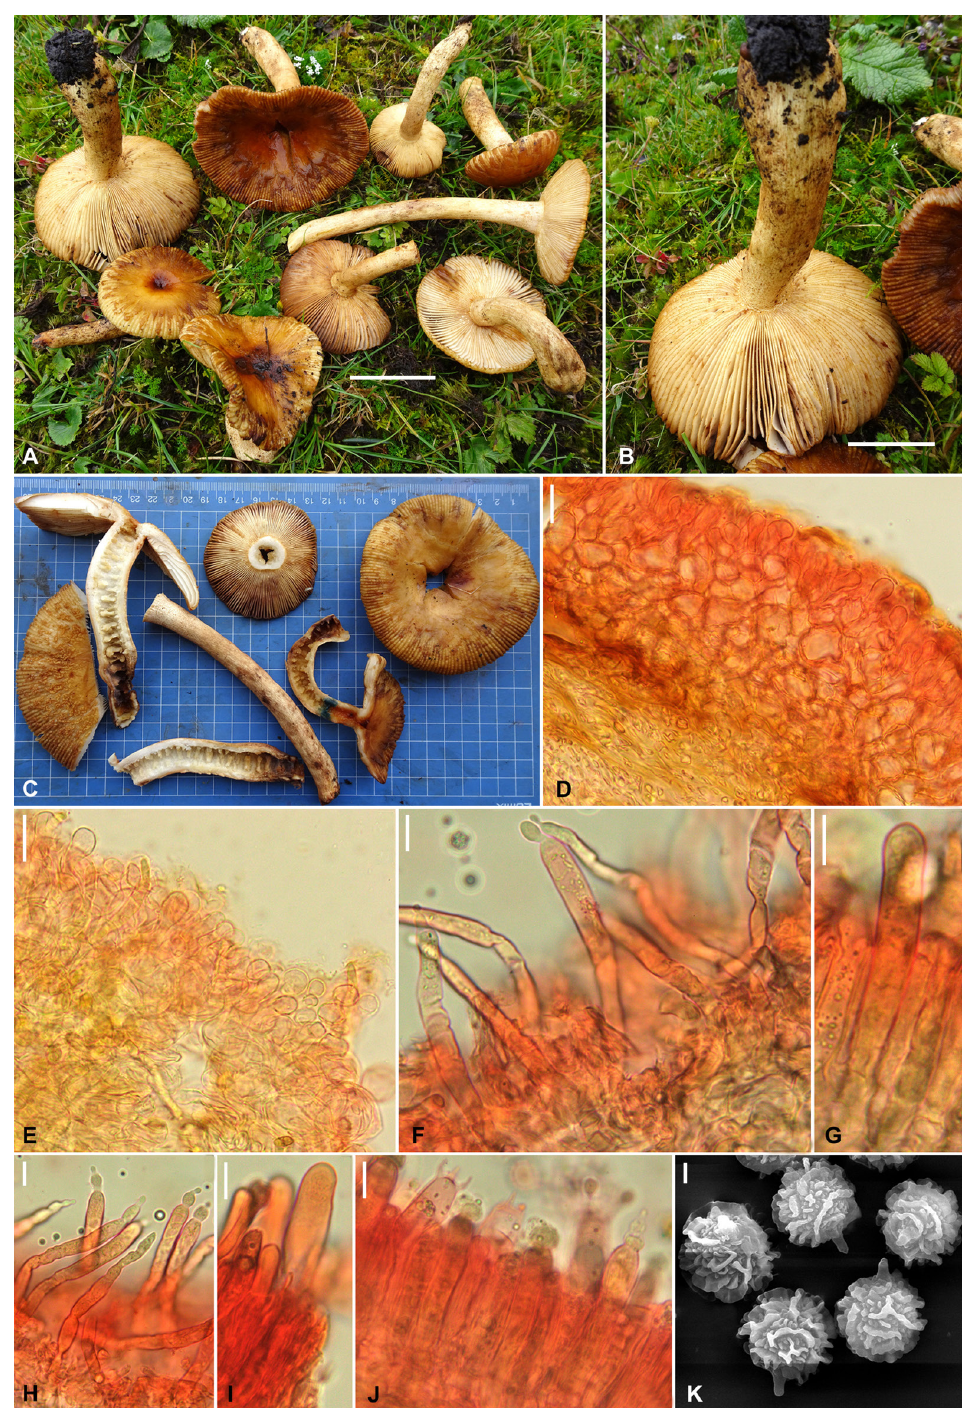
Fig. 2. Russula indosenecis A.Ghosh, D.Chakr., K.Das & Buyck sp. nov. (from holotype, AG-21-06A ). A–C . Fresh and dissected basidiomata in the field and basecamp. D–E . Transverse section through pileipellis showing elements. F–H . Transverse section through lamellae showing hymenial cystidia near the lamellae sides. I . Transverse section through lamellae showing hymenial cystidia near the lamellae edges. J . Transverse section through lamellae showing hymenial cystidia near the lamellae sides and basidia. K . SEM micrograph of basidiospores. Scale bars: A–B = 50 mm; D–E = 20 μm; F–J = 10 μm; K = 2